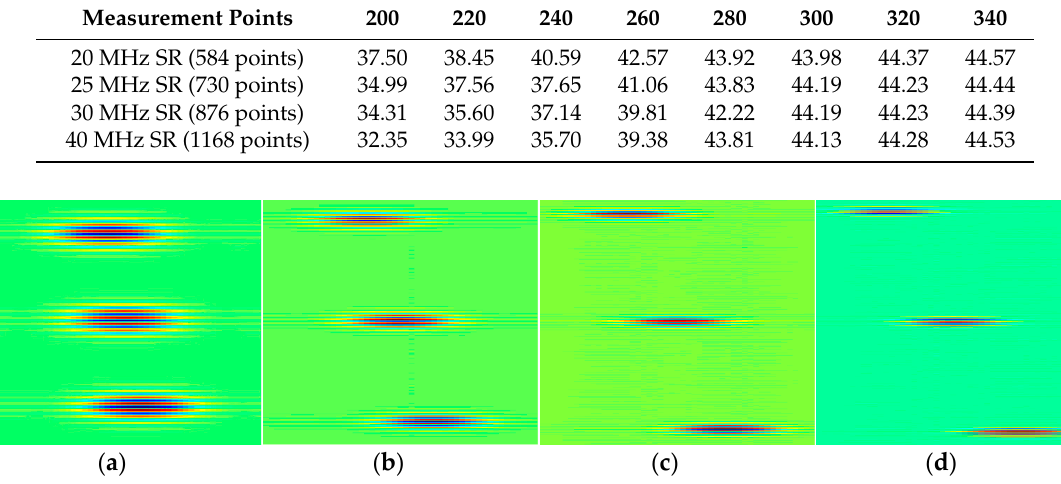
Figure 5. The recovery results of 25 MHz SR (CR = 60%) images in time domain when the distance of defects is different ( a ) D = 2 mm, PSNR = 45.62 dB; ( b ) D = 4 mm, PSNR = 45.33 dB; ( c ) D = 6 mm, PSNR = 45.17 dB; ( d ) D = 8 mm, PSNR = 44.25 dB.